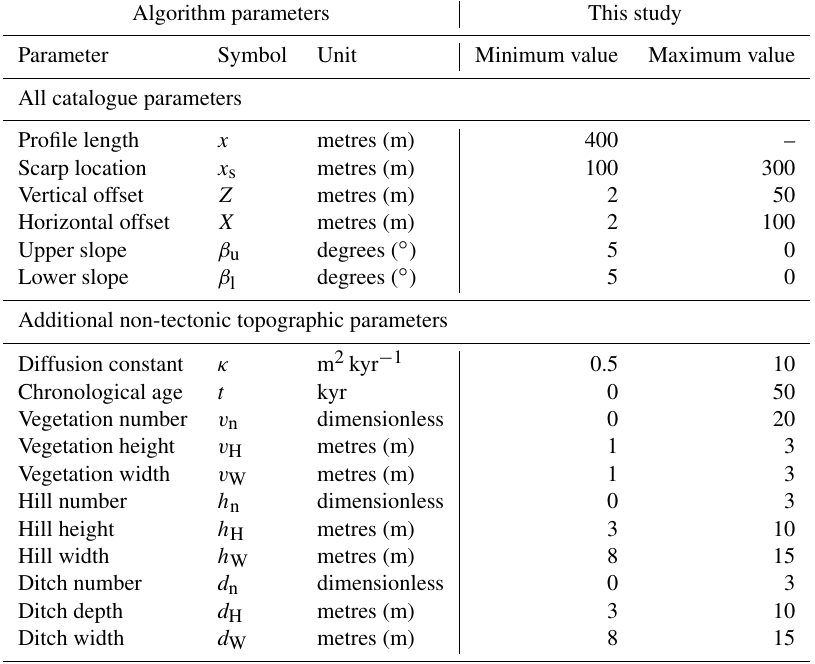
Table 1. Parameters used in creating the synthetic catalogues. Algorithm parameters This